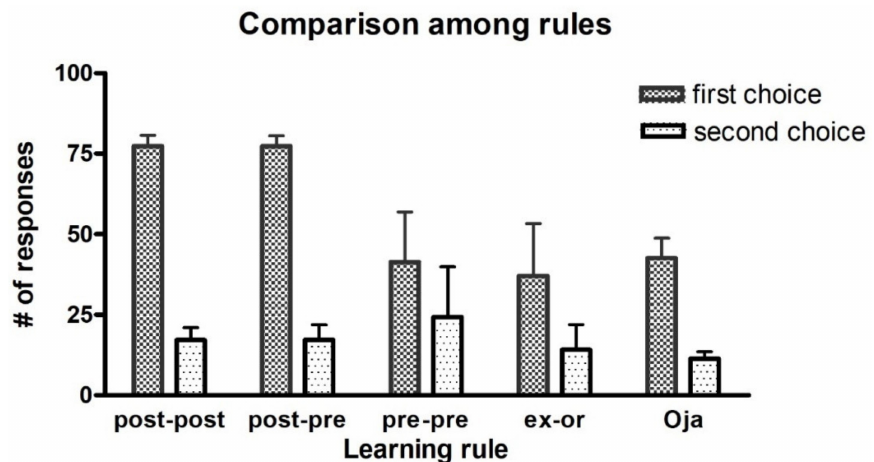
Figure 1. Test trials after 100 epochs of training. Number of correct responses for the first choice (i.e., the choice with probability reward as high as 0.8) and for the second choice (probability of reward as low as 0.3) obtained by performing 100 different test trials after 100 epochs of training, performed with the different training rules. The mean values and standard deviations refer to 10 different independent learning procedures (trained with different noise realizations). It is worth noting that the term “first choice” refers to two different possible actions, depending on the input stimulus used (the action 1 is more frequently rewarded for the stimulus S 1 , and the action 2 for the stimulus S 2 ). Each stimulus was used 50 times during the 100 test trials.